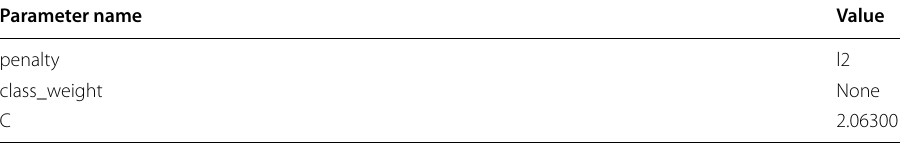
Table 64 Modes of LR tuned hyperparameter values for experiments with the information theft dataset